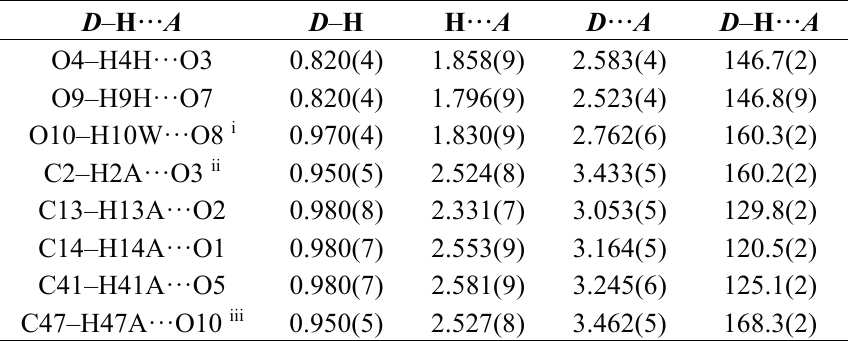
Table 3. Observed hydrogen bonds for complex 3 (Å, °).